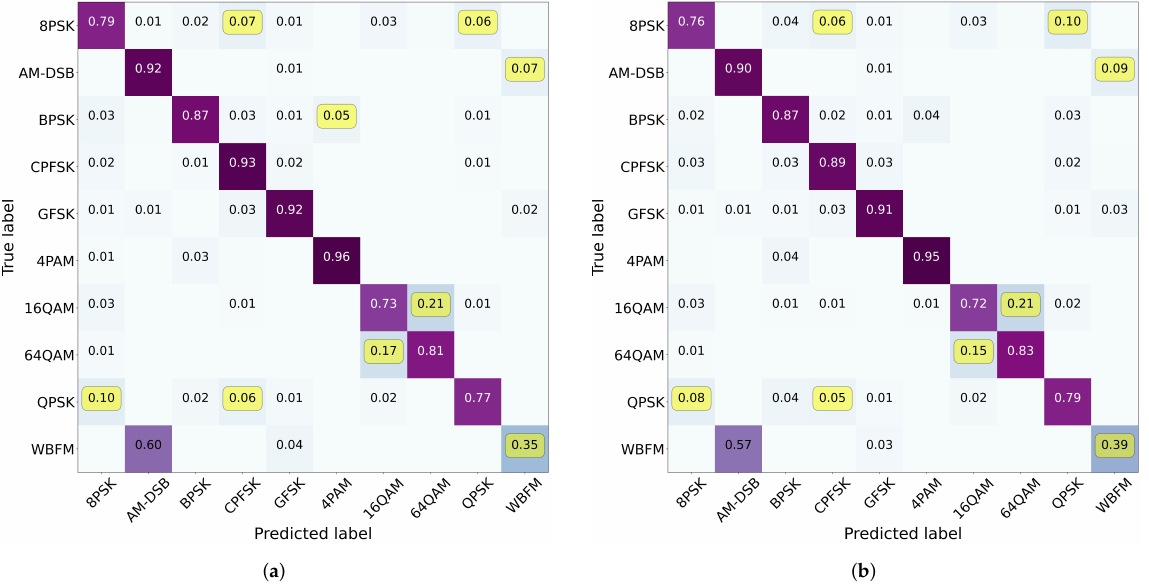
( b ) Figure A1. Confusion matrix of ( a ) SE-MSFN, ( b ) LSTM2 on the 2016A-1 dataset. Values less than 0.01 are omitted. Values greater than 0.5 in the confusion matrix are shown in purple, the darker the value, the greater the confusion. Values between 0.05 and 0.5 are shown in yellow.